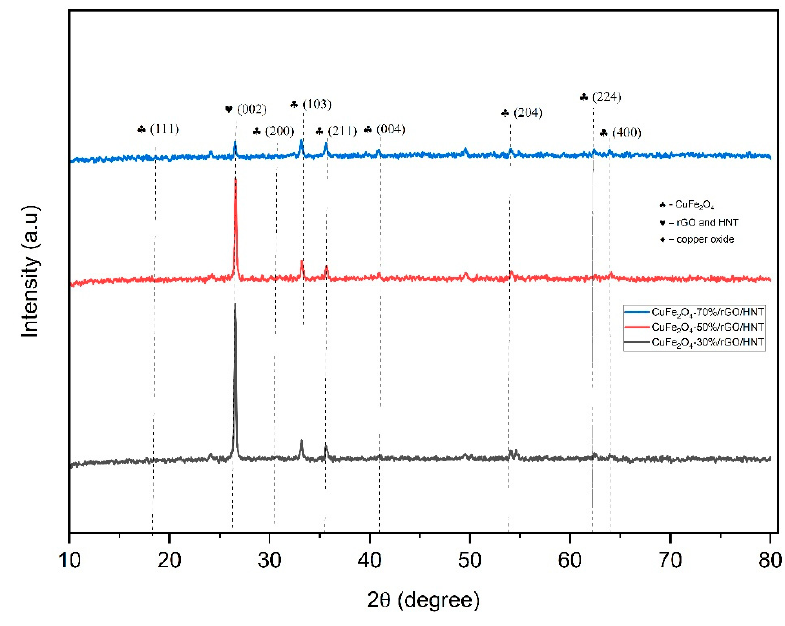
Figure 1. XRD patterns of CuFe 2 O 4 /rGO/HNT series at diffracted planes